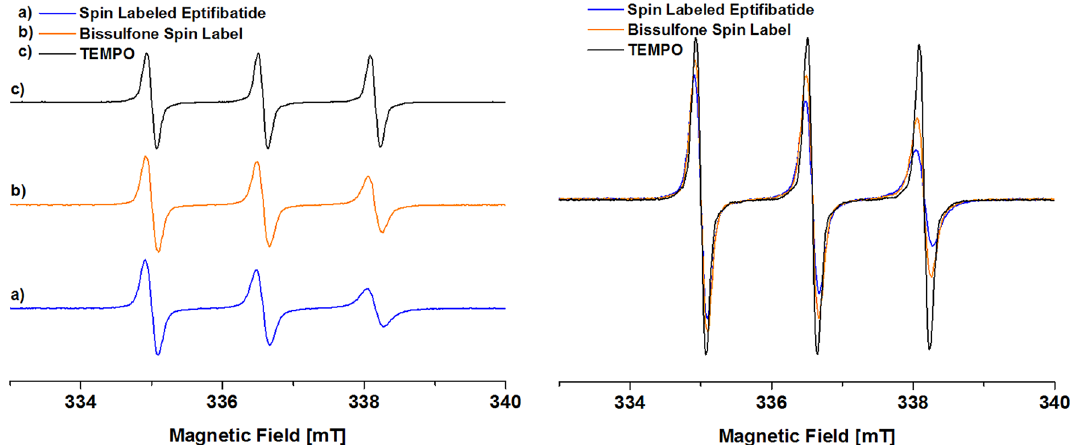
Figure 4. (a) EPR spectra of spin labeled eptifibatide 3 (blue), (b) bis-sulfone based spin label 4 (orange) and (c) TEMPO as reference (black). Note: Spectra are normalized by the maximum intensity (left side). Spectra are shown without normalization (right side). Experimental conditions were identical for all samples. Samples were measured at concentrations of 1 mM in DMSO at 293